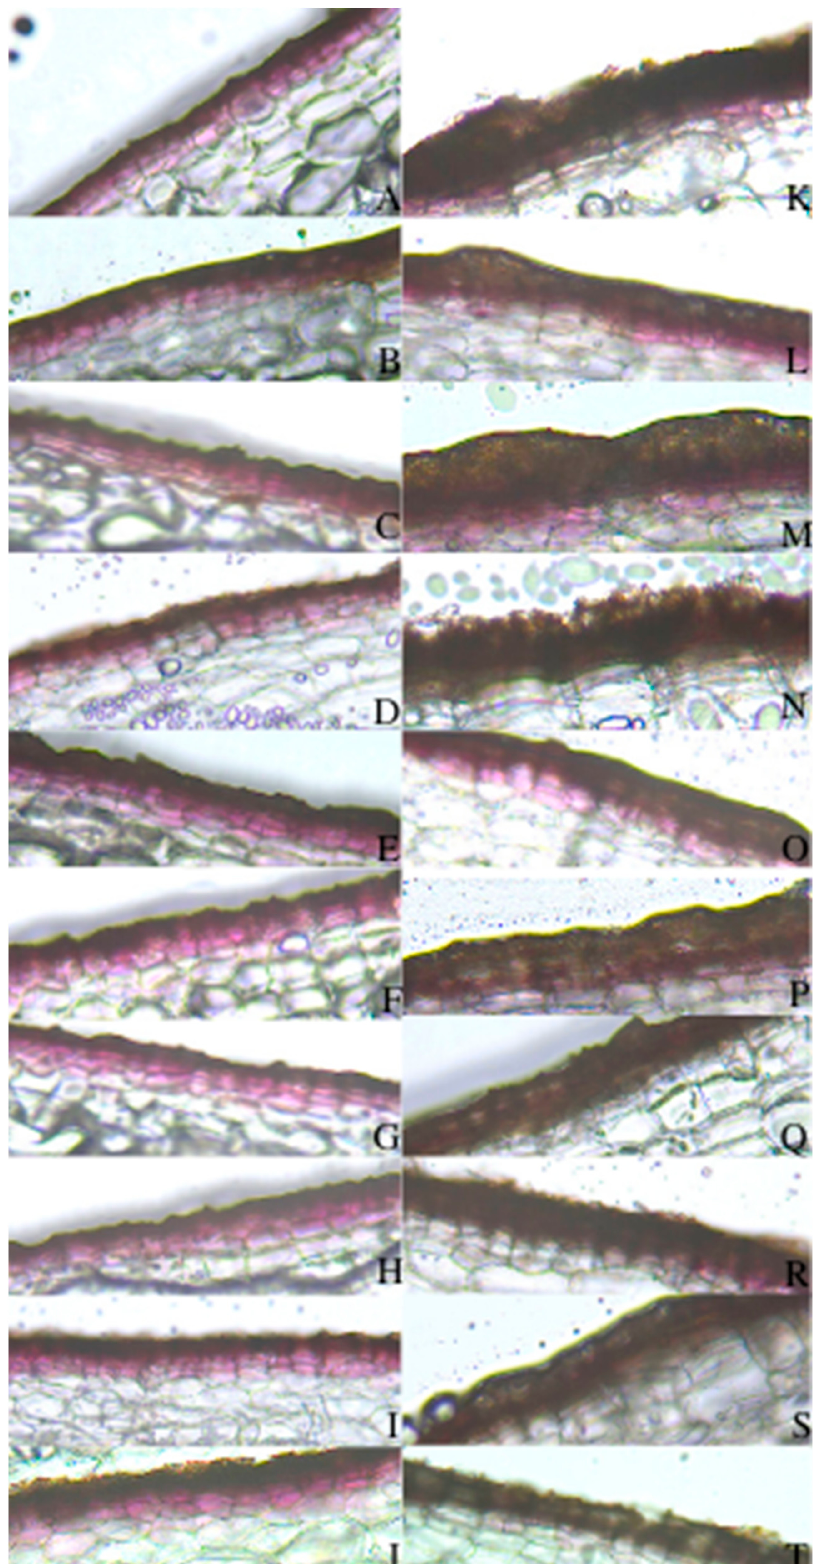
Figure 6. Photos comparison between normal skin ( A – J on the left column) and silver patch skin ( K – T on the right column) of Dark Red Norland tubers under bright field microscopy observation.